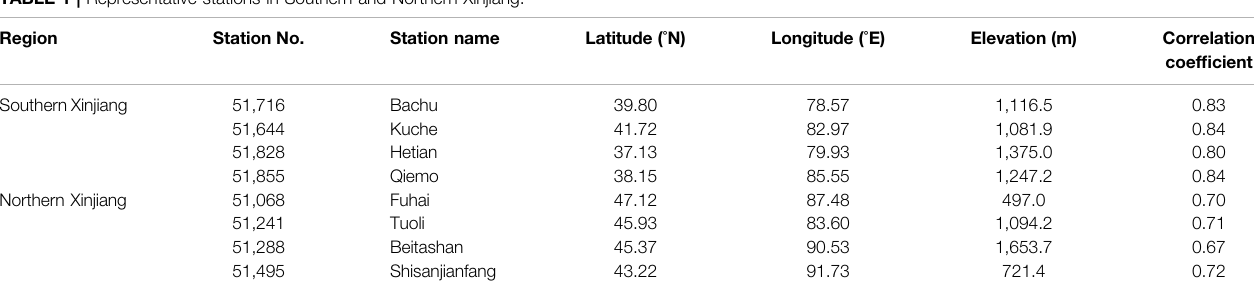
TABLE 1 | Representative stations in Southern and Northern Xinjiang. Region Station